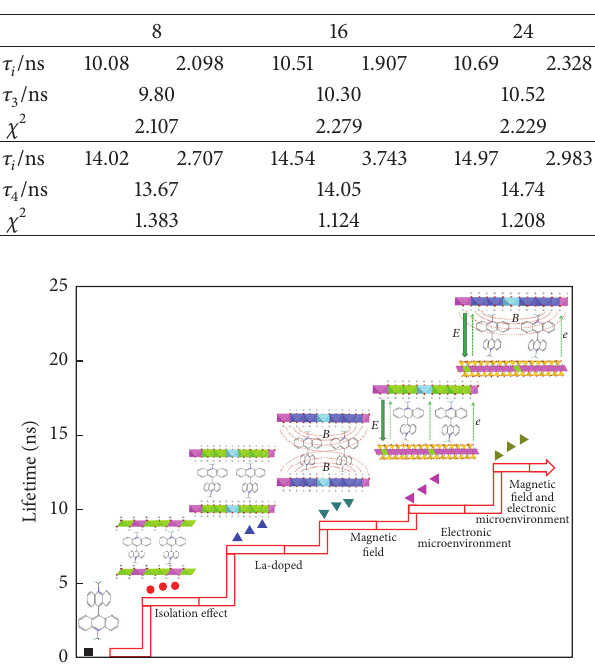
Table 2: Lifetimes of luminescent thin films based on CoAlLa- LDHs. 𝜏 3 stands for the lifetime of Co( 𝑛 )-films and 𝜏 4 stands for the lifetime of CoM( 𝑛 )-films.